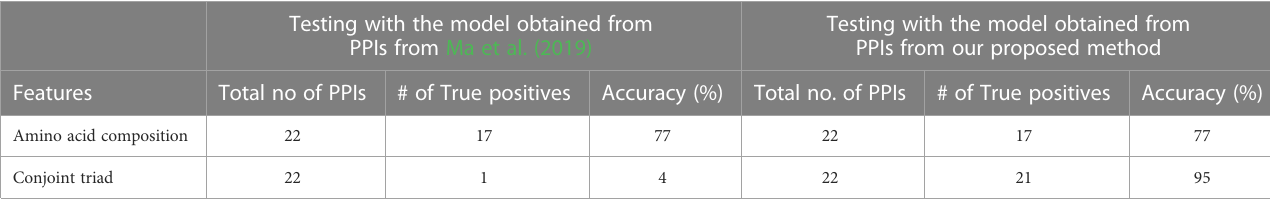
TABLE 7 SVM-based comparative prediction result of amino acid composition and conjoint triad features in the experimental veri fi ed dataset with the Ma et al. (2019) model and our proposed model. Testing with the model obtained from Testing with the model obtained from PPIs from Ma et al. (2019) PPIs from our proposed method Features # of True positives Accuracy (%) Total no. of